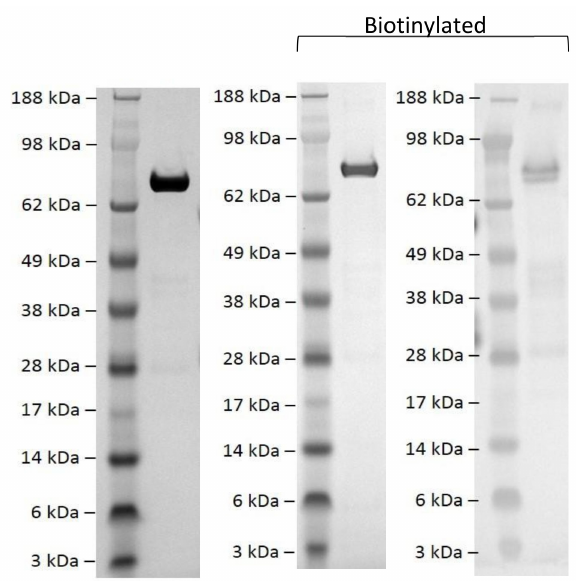
Figure 1. Biotinylation of EPAC1 ∆ DEP protein. EPAC1 ∆ DEP-GST protein was expressed and purified from E.coli and the GST removed by limited proteolysis (left panel). EPAC1 ∆ DEP was then biotinylated as confirmed by SDS-PAGE and Coomassie staining (center panel) and Western blotting (right panel). SeeBlue Plus2 protein markers were used for size comparison. Table 1. Summary of phage-display selection methods. Six different phage-display screens were carried out using biotinylated EPAC1 ∆ DEP as a target (screens S01–S06). Pre-panning deselection and off-rate deselection was